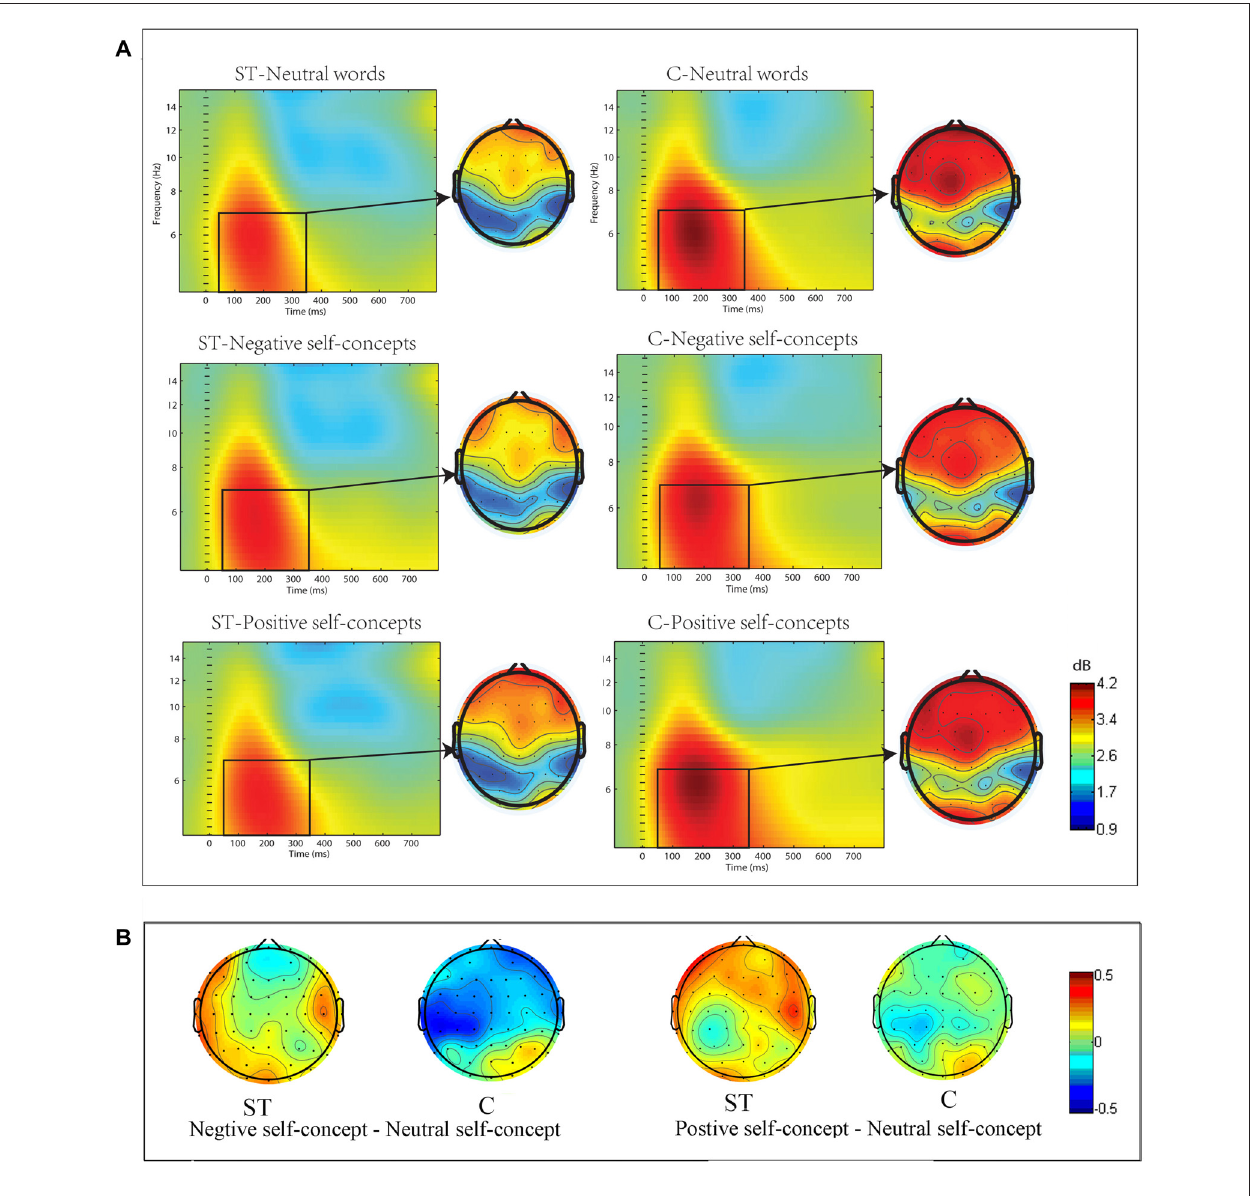
FIGURE 2 | (A) The event-related spectral perturbation (ERSP) elicited by neutral words, positive self-concepts and negative. self-concepts at P7 (an electrode point was randomly selected to serve as the representative of the electrode points in left posterior area) in aging ST and control groups (C) were presented by square chart. Red represented enhanced power and blue represented reduced power, dB was the unit. The topographical maps on the right side of the square chart illustrate the energy distribution for 4–7 Hz at 50–350 ms for each condition. (B) Topographic maps of differences between different self-concept valances in control and aging stereotype condition for 4–7 Hz at 50–350